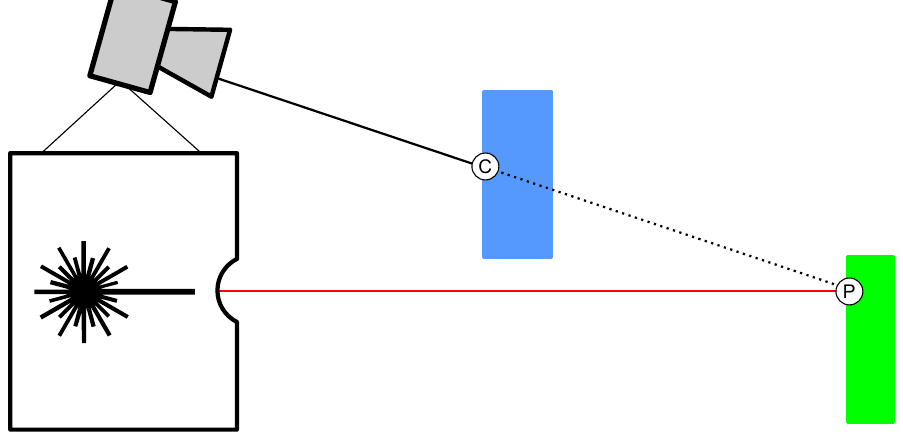
Figure 3. Occurrence of an error in assigning a colour to a specific position of an object’s surface. Designated surface position—P, colour reading location—C.